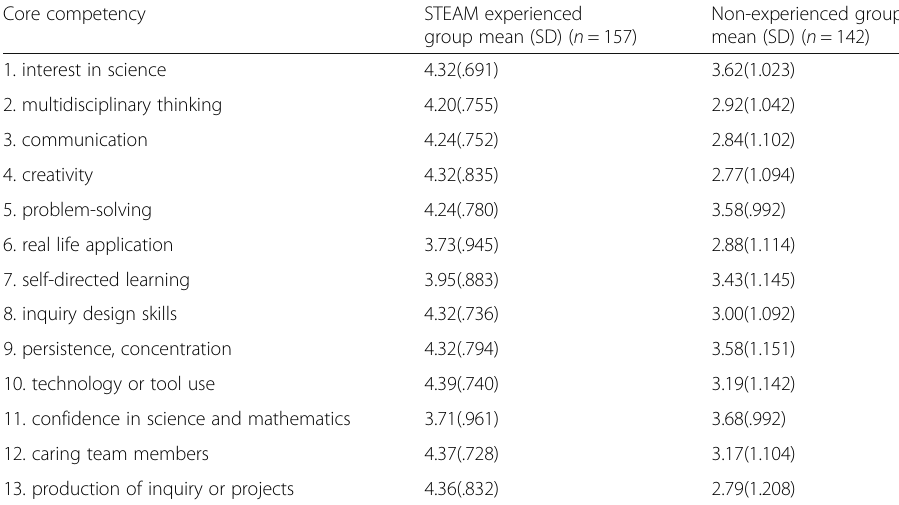
Table 4 Student perceived STEAM effect on core competencies (modified from Kang, Im, et al., 2018, p.